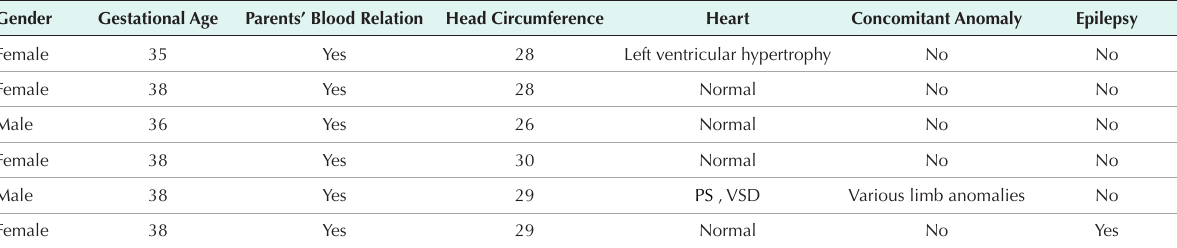
Table 2. Patients’ Microcephaly Description